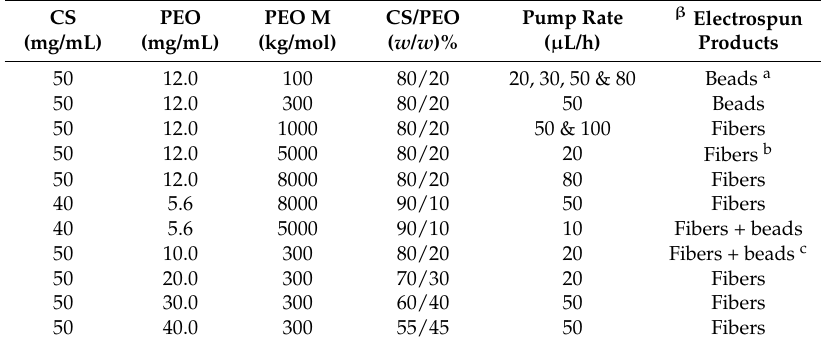
Table 2. Composition of electrospun solutions obtained with different molecular weights PEO added into chitosan CS ( M W = 102 kg/mol) in 0.5 M acetic acid solution at 20 kV applied voltage.